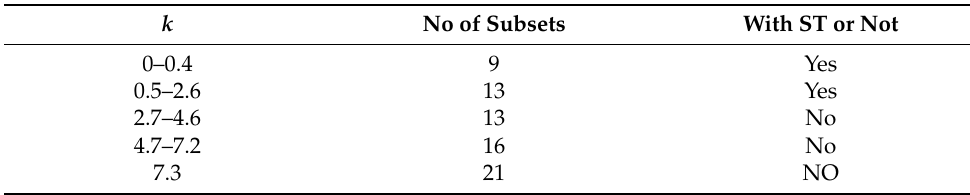
Table 1. The relationship of subsets and shared turbines (ST) with different k